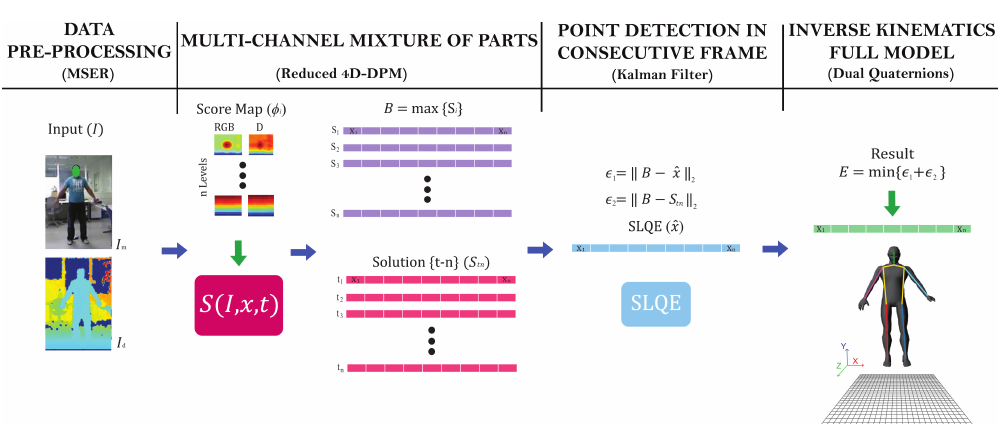
Figure 1. Outline of our